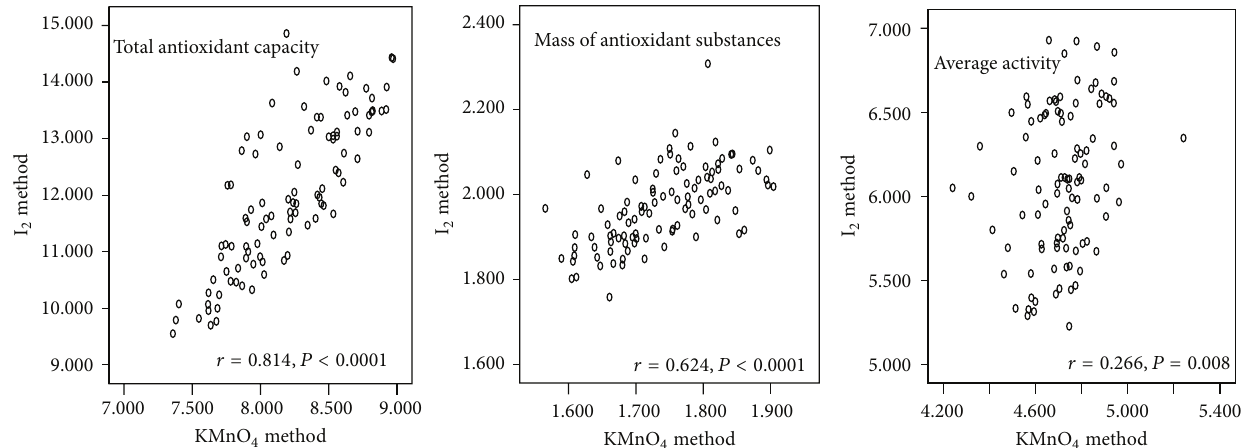
Figure 3: Correlation of potassium permanganate method with iodimetric method for determination of total antioxidant capacity, average serum antioxidant activity, and mass of antioxidants in serum.